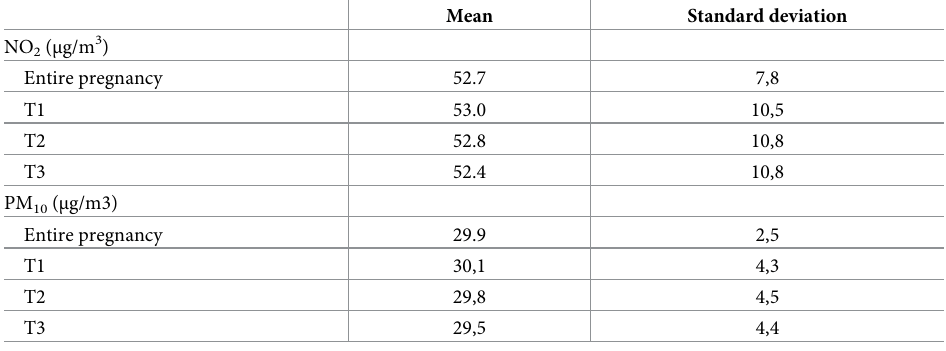
Table 2. Mean concentrations of NO 2 and PM 10 (in μ g/m 3 ) and standard deviations during four windows of expo- sure: Entire pregnancy and first (T1), second (T2) and third (T3) trimesters of pregnancy.